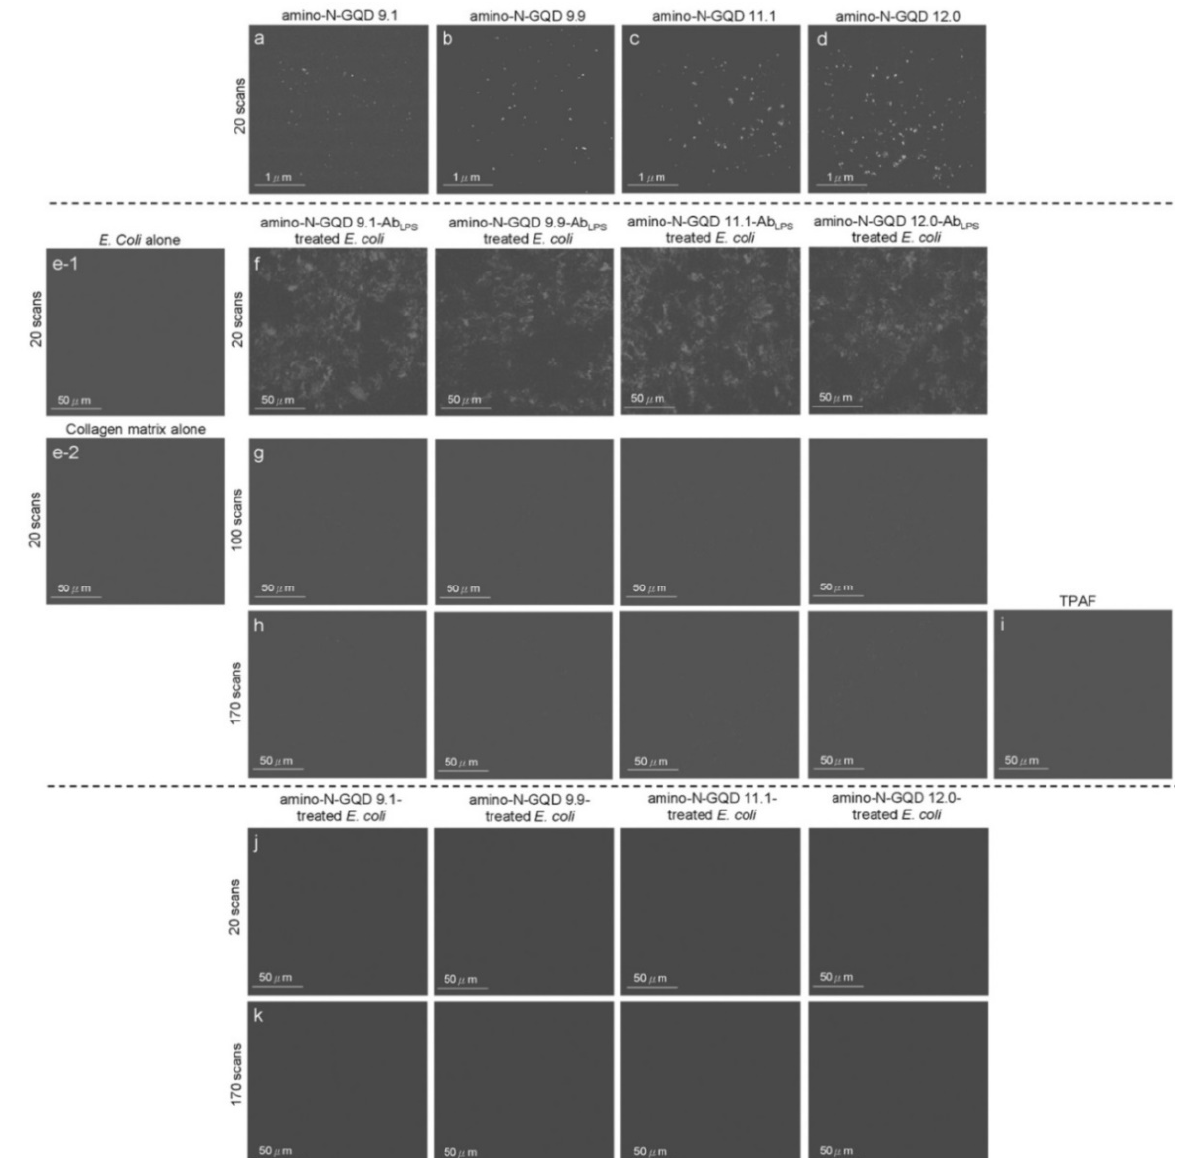
Figure 3. TPL images (gray-level) of the ( a ) amino-N-GQD 9.1, ( b ) amino-N-GQD 9.9, ( c ) amino-N- GQD 11.1, and ( d ) amino-N-GQD 12.0 at a TPE power of 222.7 nJ pixel − 1 with 20 scans. ( e-1 ) E. coli alone, ( e-2 ) collagen matrix alone and bacteria subjected to sorted amino-N-GQD–Ab LPS treatment at a 180 μ m depth (222.7 nJ pixel − 1 ) with ( f ) 20 scans and ( g ) 100 scans through TPE. ( h ) Images acquired after an additional 170 scans. ( i ) TPAF image of the unlabeled bacteria. TPL images of bacteria treated without the antibody-coated materials with ( j ) 20 scans and ( k ) 170 scans through photoexcitation under the same conditions. All images were acquired after 3 h of additional incubation to make the PDT action effectively. TPE wavelength: 960 nm. Delivered dose (OD 600 ): approximately 0.05 of E. coli or 0.75 µ g mL − 1 material–Ab LPS .